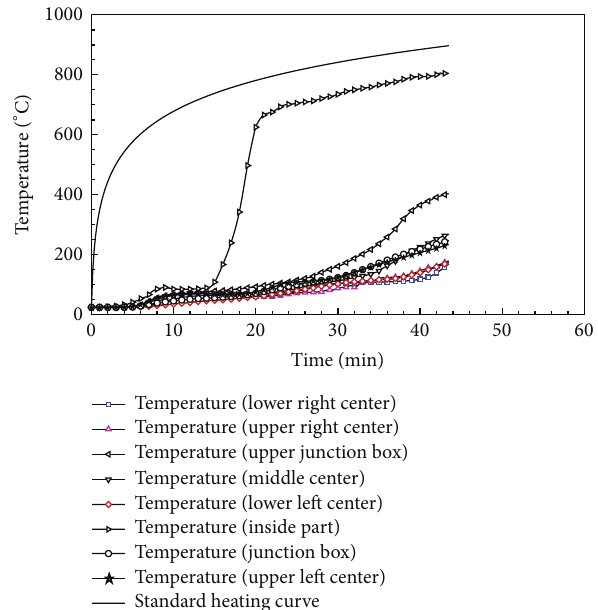
Figure 8: Time-temperature chart for the specimen in Test 4.